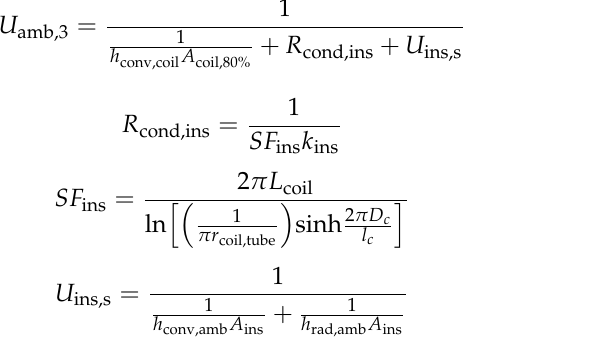
the heat loss from the fluid in the tank to the ambient air is expressed in Equation